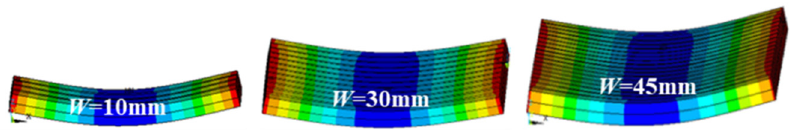
Figure 6. Vibration mode of piezoelectric composite double-laminated.